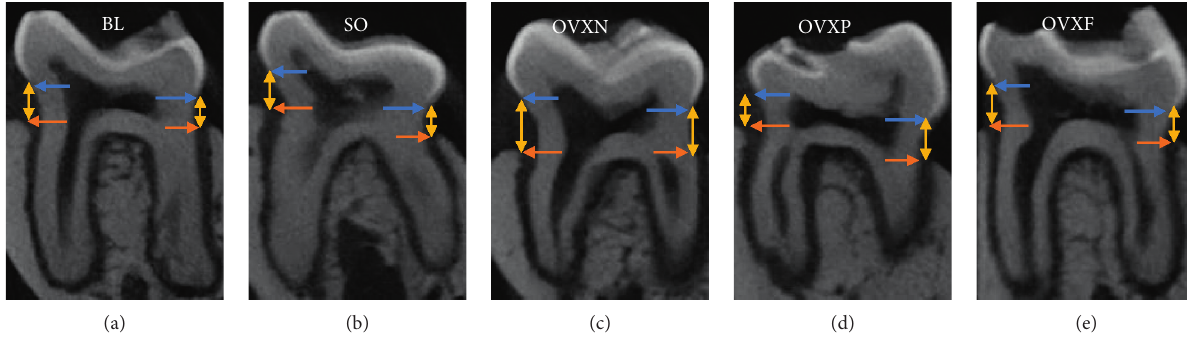
Figure 4: Coronal sections of the alveolar bone showing the height of the bone loss from the CEJ ( ) to ABC ( ) of M1 (CEJ-ABC is represented by ) of all groups. B, buccal; L, lingual.